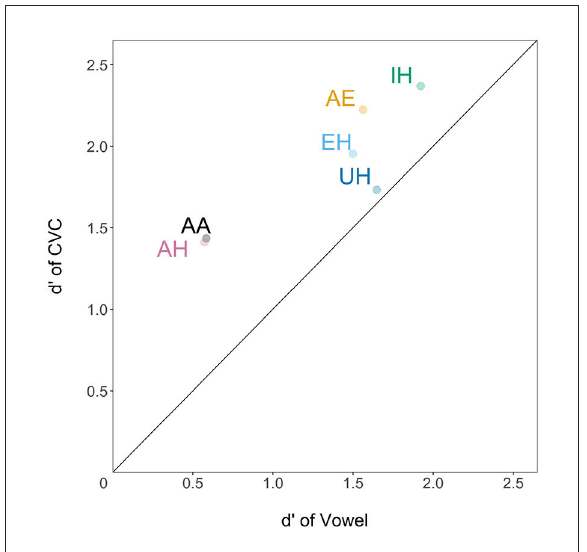
FIGURE4 d’ ( Zscore ( hit ) − Zscore ( false alarm ) ) for each vowel in vowel-only condition (X-axis) vs. d’ of same vowels in CVC condition (Y-axis). All vowel labels are in ARPAbet. Every vowel sound in the CVC condition was above the center line indicating that the d’ was higher than in the vowel-only